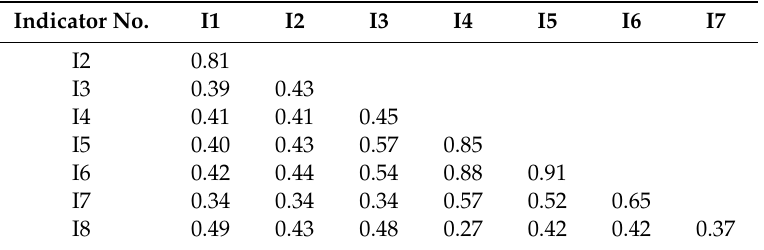
Table 5. Pearson correlation coe ffi cients.